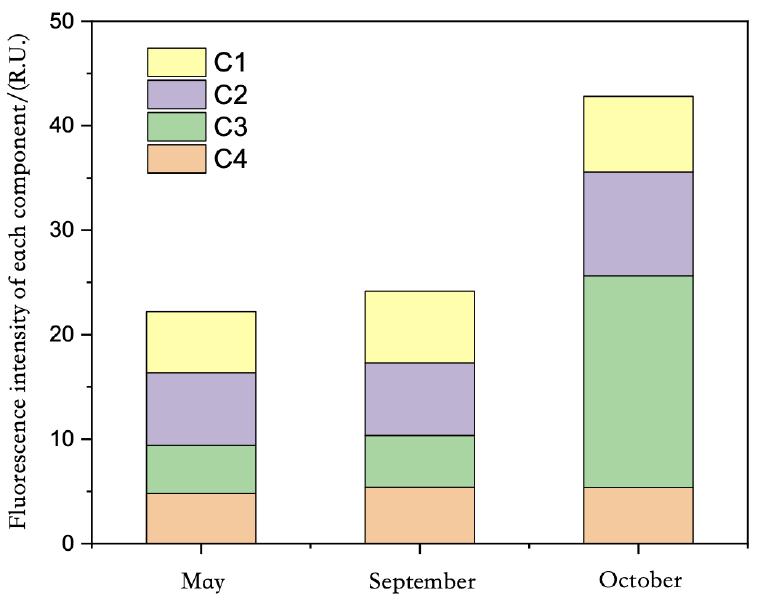
Figure 13. Fluorescence intensity characteristics of components of DOM in Qinghai Lake.